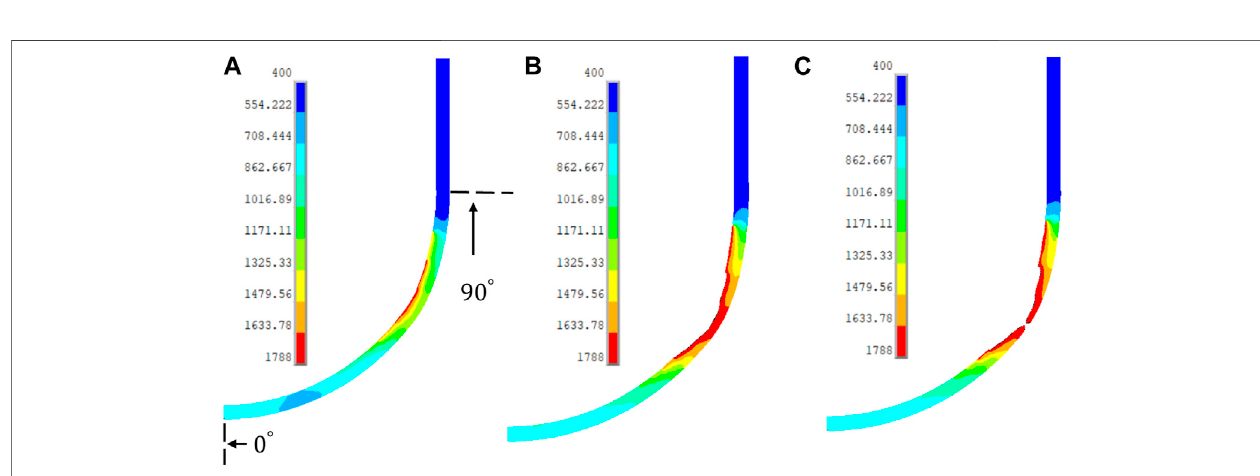
FIGURE 7 | Dynamic ablation for the SBO + LOCA case: temperature distribution (K) at time (A) t = 6 h, (B) t = 7.16, and (C) t = 7.33 h.